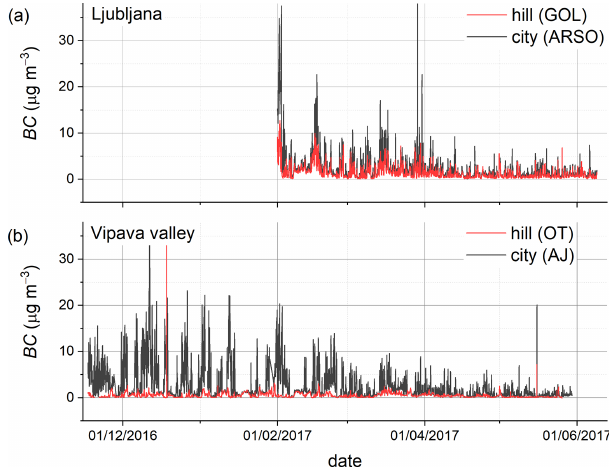
Figure 4. Time series (1h running average is applied to 1min data) of black carbon concentration (BC) measured at two measurement sites (city – black, hill – red) in Ljubljana (a) and in Vipava val- ley (b)